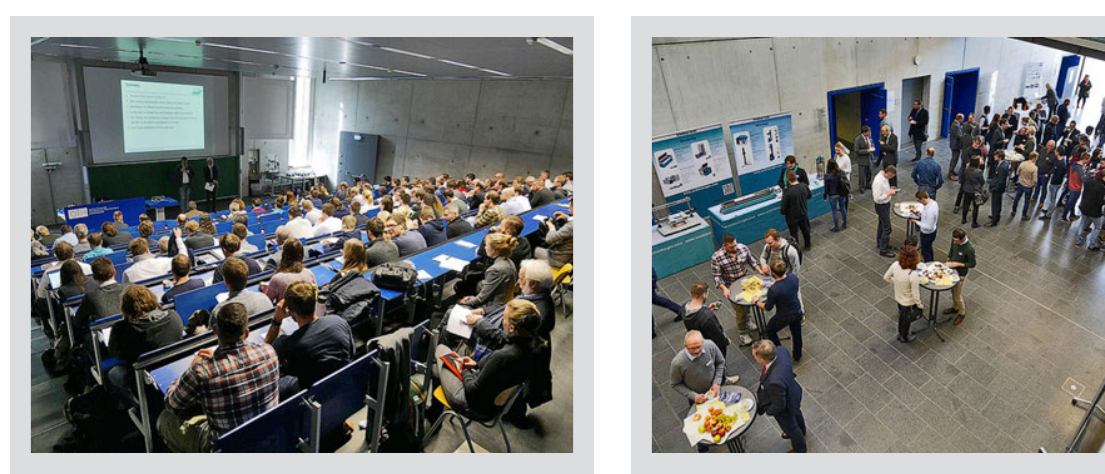
Figure 2: Breaks between the lectures for exchange of opinions and